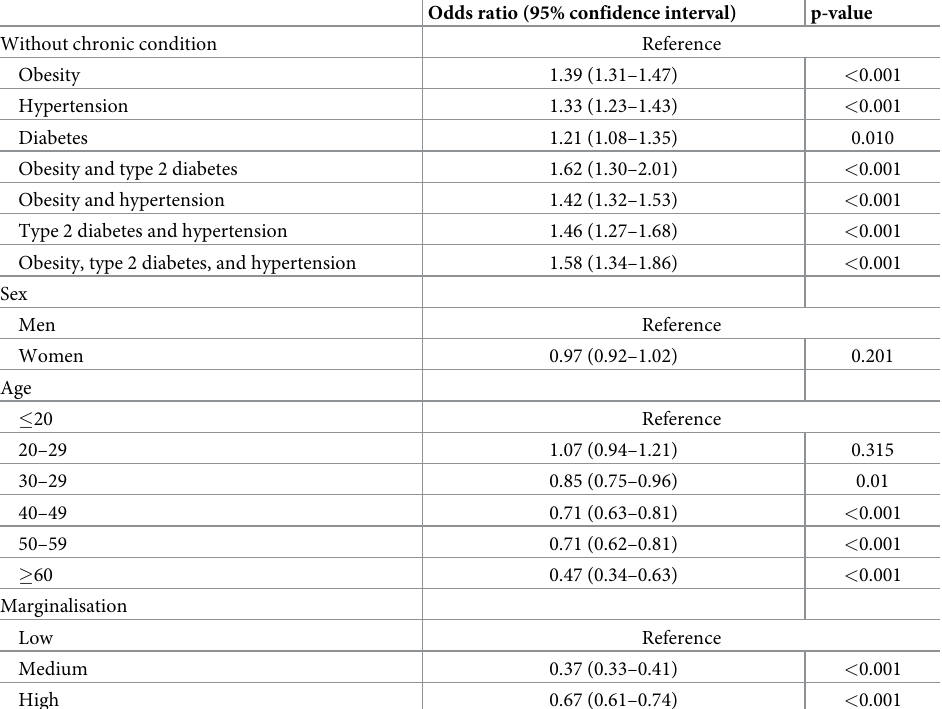
Table 4. Odds ratios for SARS-CoV-2 infection according to presence of non-communicable diseases, sex, age, and marginalisation (N =